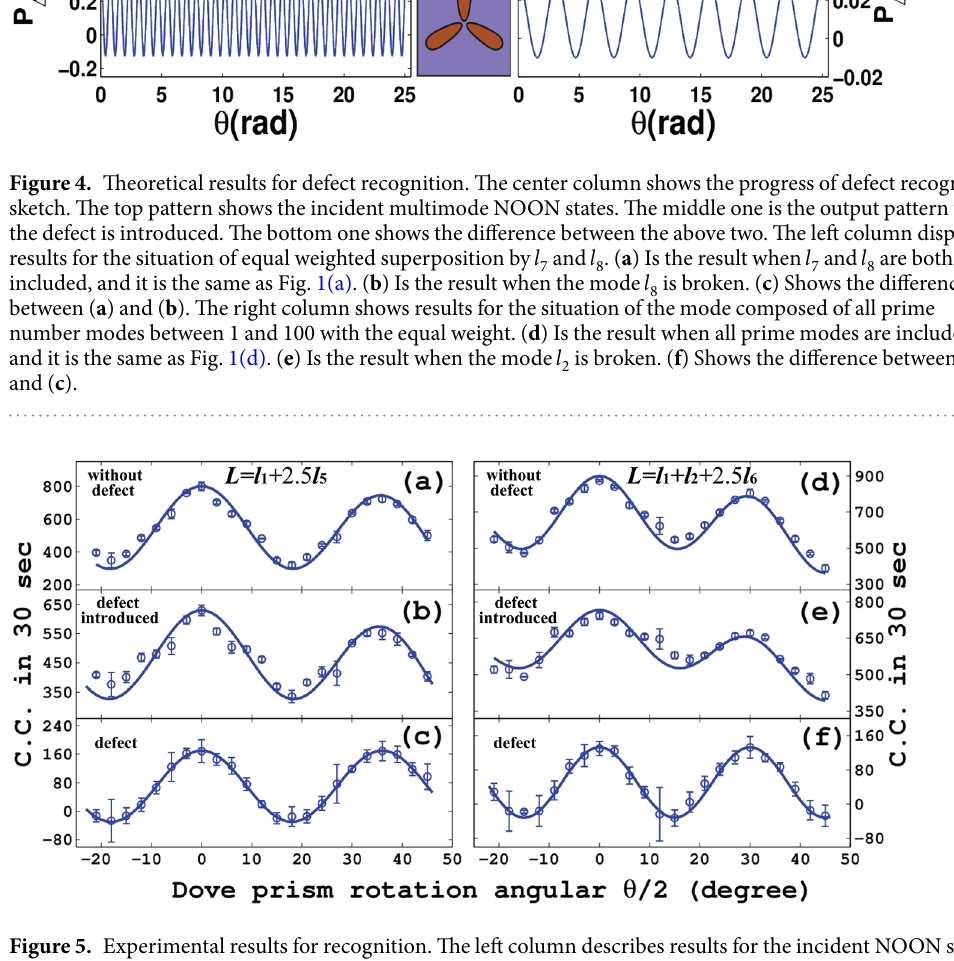
Figure 5. Experimental results for recognition. The left column describes results for the incident NOON state with = + . L l l 2 5 . ( a ) Is the result when the iris is open and it is part of Fig. 2(a). ( b ) Is the result when the iris 1 5 is partly closed to block the mode l . ( c ) Shows the difference between ( a ) and ( b ). The right column shows 5 results for the incident NOON state with = + + . L . ( d ) Is the result when the iris is open and it is part 6 of Fig. 2(b). ( e ) Is the result when the iris is partly closed to block the mode l . ( f ) Shows the difference between 6 ( d ) and ( e ). The round dots and solid lines represent the experimental and theoretical results,